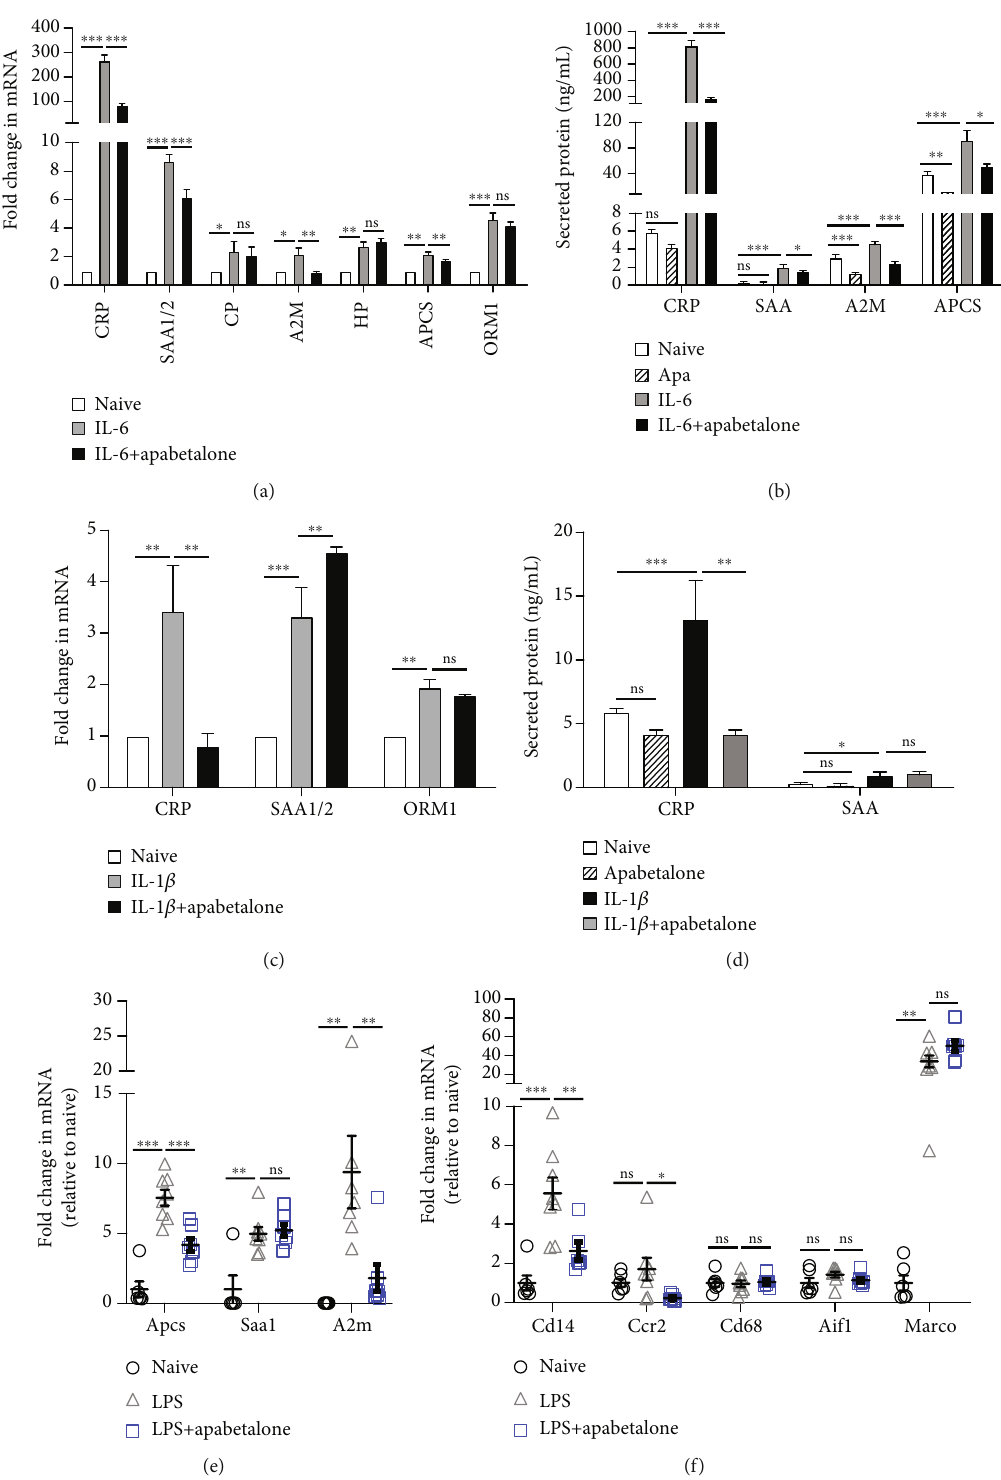
Figure 2: Apabetalone downregulates cytokine-induced expression of APR genes in hepatocytes. (a, b) Apabetalone (25 μ M) reduces IL-6 mediated induction (72 h) of CRP , A2M , and APCS mRNA (rtPCR) (a) and protein (ELISA) (b). Data is presented as the mean ± S : D : (c, d) Apabetalone (25 μ M) reduces IL-1 β -mediated induction of CRP mRNA (c) and protein (d). Data is presented as the mean ± S : D : (e) Hepatic APR gene expression is downregulated by apabetalone in the LPS mouse model of systemic in fl ammation (rtPCR, 24 h